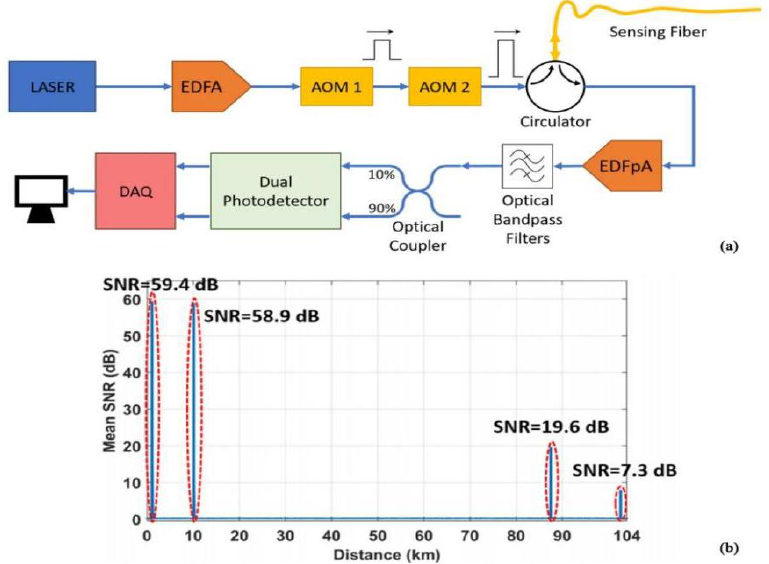
Figure 18. ( a ) Experimental setup. ( b ) Mean SNR versus distance along the test fiber [72]. Table 6. Research progress for detection distance